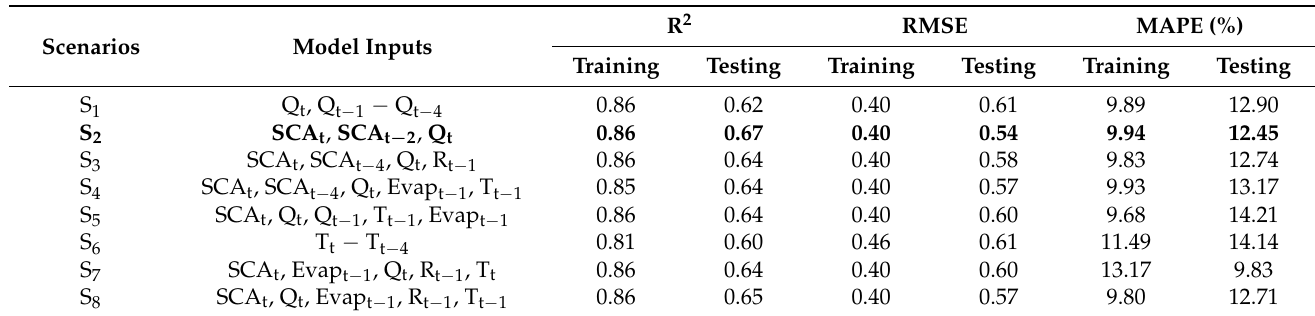
Table 4. Training and testing statistics of the ANN algorithm using various input combinations for the Gilgit River basin.